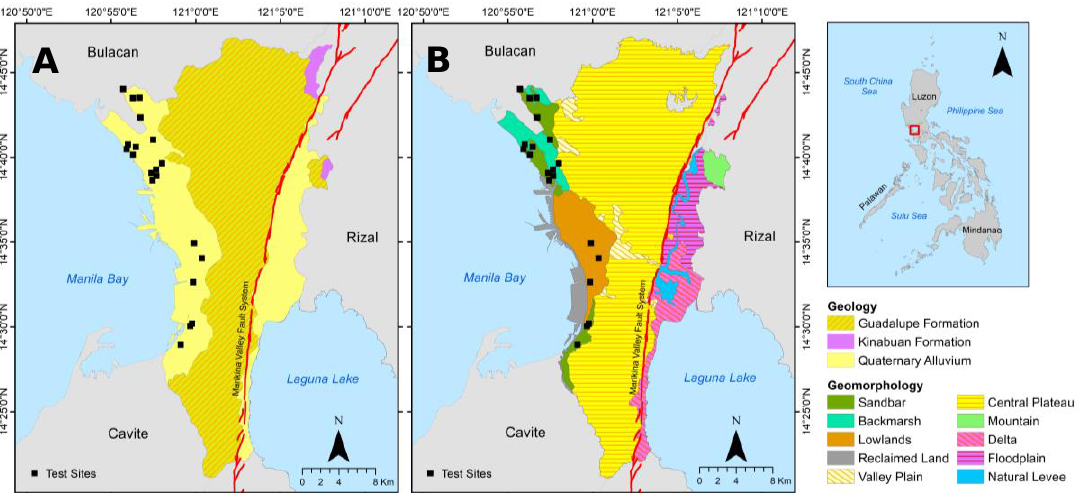
Figure 1. ( A ) Geological and ( B ) geomorphologic map of Metro Manila, Philippines, and the locations of the refraction microtremor surveys. Geologic map modified from BMG (1983) [38] and geomorphologic map obtained from MMIERS (2004) [39]. Locations of the testing sites are also depicted in black squares.